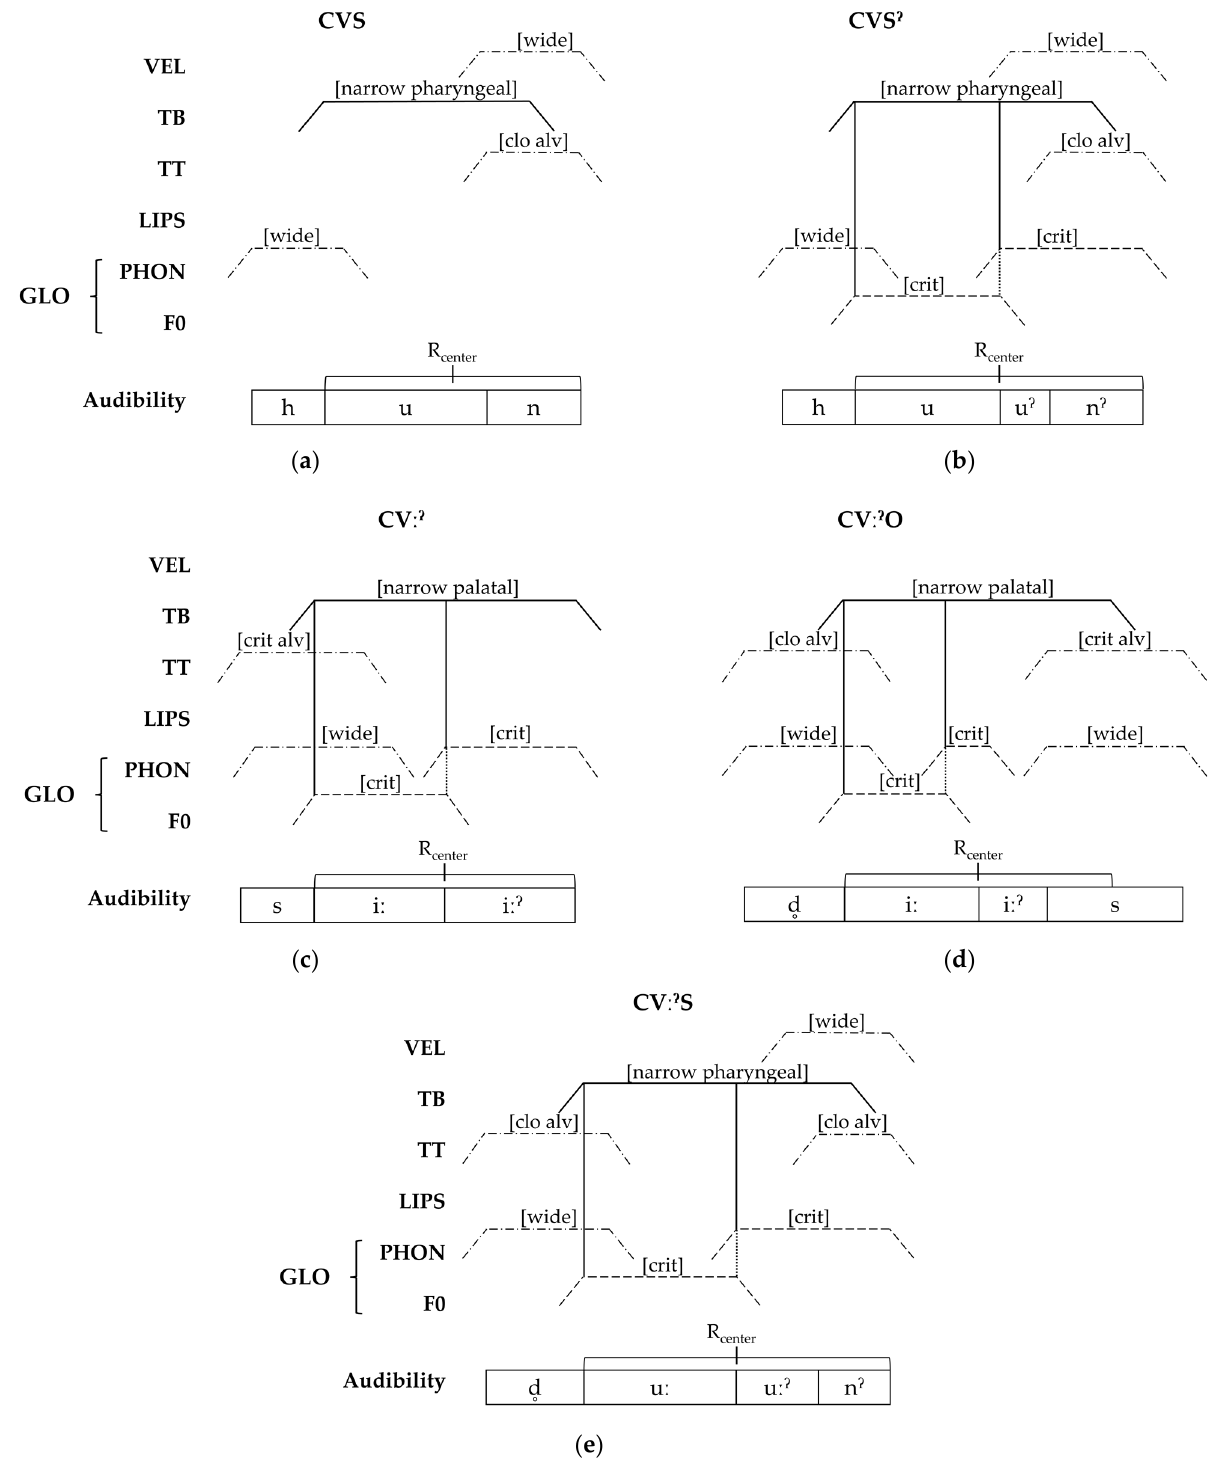
Figure 14. Gestural scores of stød coordination for CVS ˀ , CV ːˀ , CV ːˀ O, and CV ːˀ S words. An example of a CVS word is provided for reference. ( a ) Gestural coordination for CVS word [hun] ‘she’; ( b ) Gestural coordination in the CVS ˀ word [hun ˀ ] ‘dog’; ( c ) Gestural coordination in the CV ːˀ word [si ːˀ ] ‘sieve’; ( d ) Gestural coordination in the CV ːˀ O word [ d̥ i ːˀ s] ‘fog’; ( e ) Gestural coordination in the CV ːˀ S word [ d̥ u ːˀ n] ‘down (feathers)’.